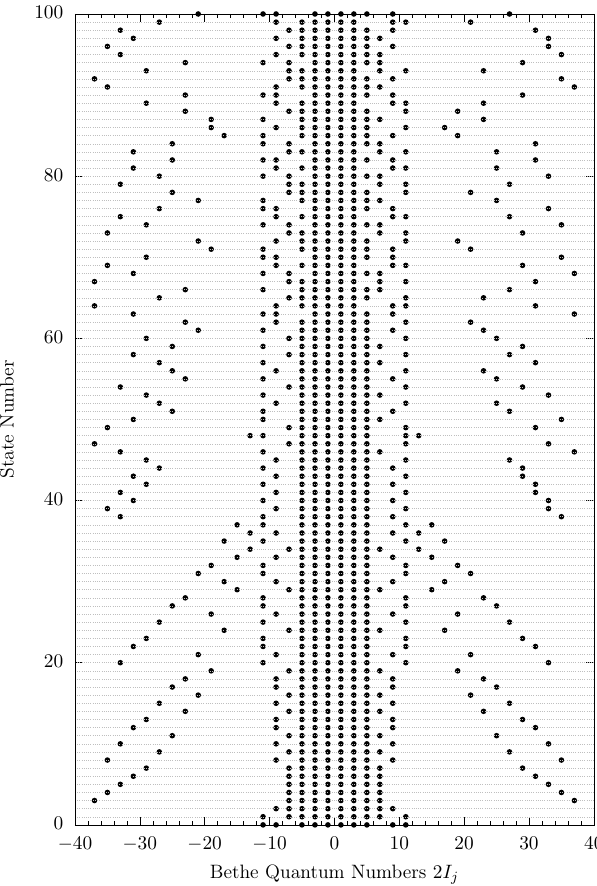
} , see Eq. (8), characterizing j ) j